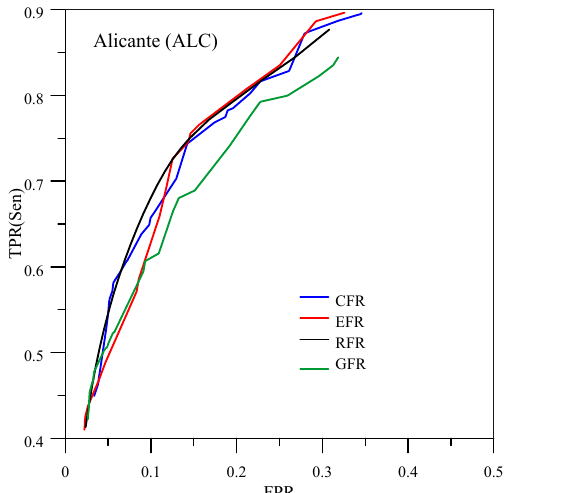
Figure 4. Behaviour of the calculation methods for each province. ROC plots are shown in the left column and pAUC evolution in the right column.